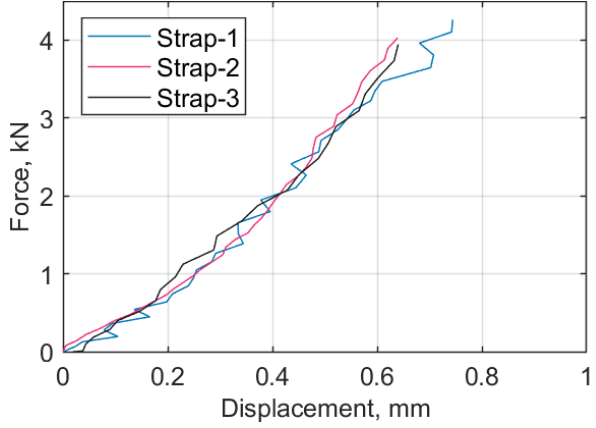
Figure 14. Shape change of prestressed straps ( top ) vs. non-prestressed straps ( bottom ).